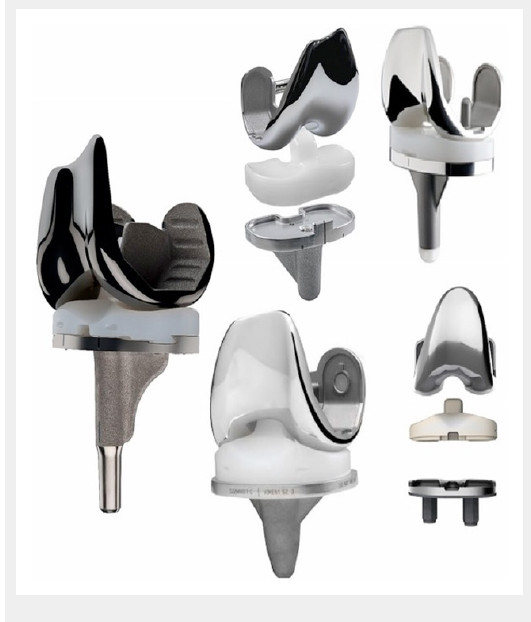
Illustration of a few of the currently available total knee arthroplasty